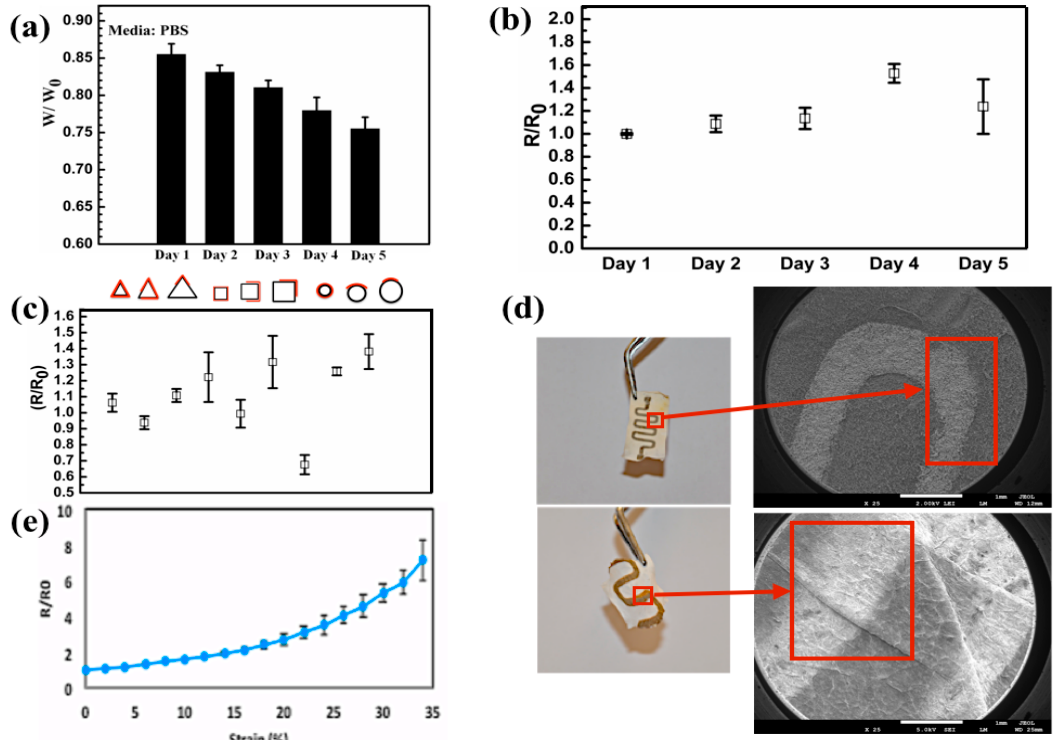
Figure 3. ( a ) Weight loss of the conductive patterns over 5 days in PBS. ( b ) Electrical resistance (R) of the conductive pattern over 5 days in PBS with respect to the original resistance after fabrication. ( c ) Repeated measurements from Figure 2d during degradation in PBS over 5 days. ( d ) Optical image representation of the conductive pattern after the fifth day of degradation and enlarged versions of low magnification FESEM images that show the degradation effect on the surface of the substrate. ( e ) Elasticity and flexibility of the electrospun electronics device that shows the value of electrical resistance of the stretched pattern ( R ) with the value in the un-stretched condition ( R 0 ).